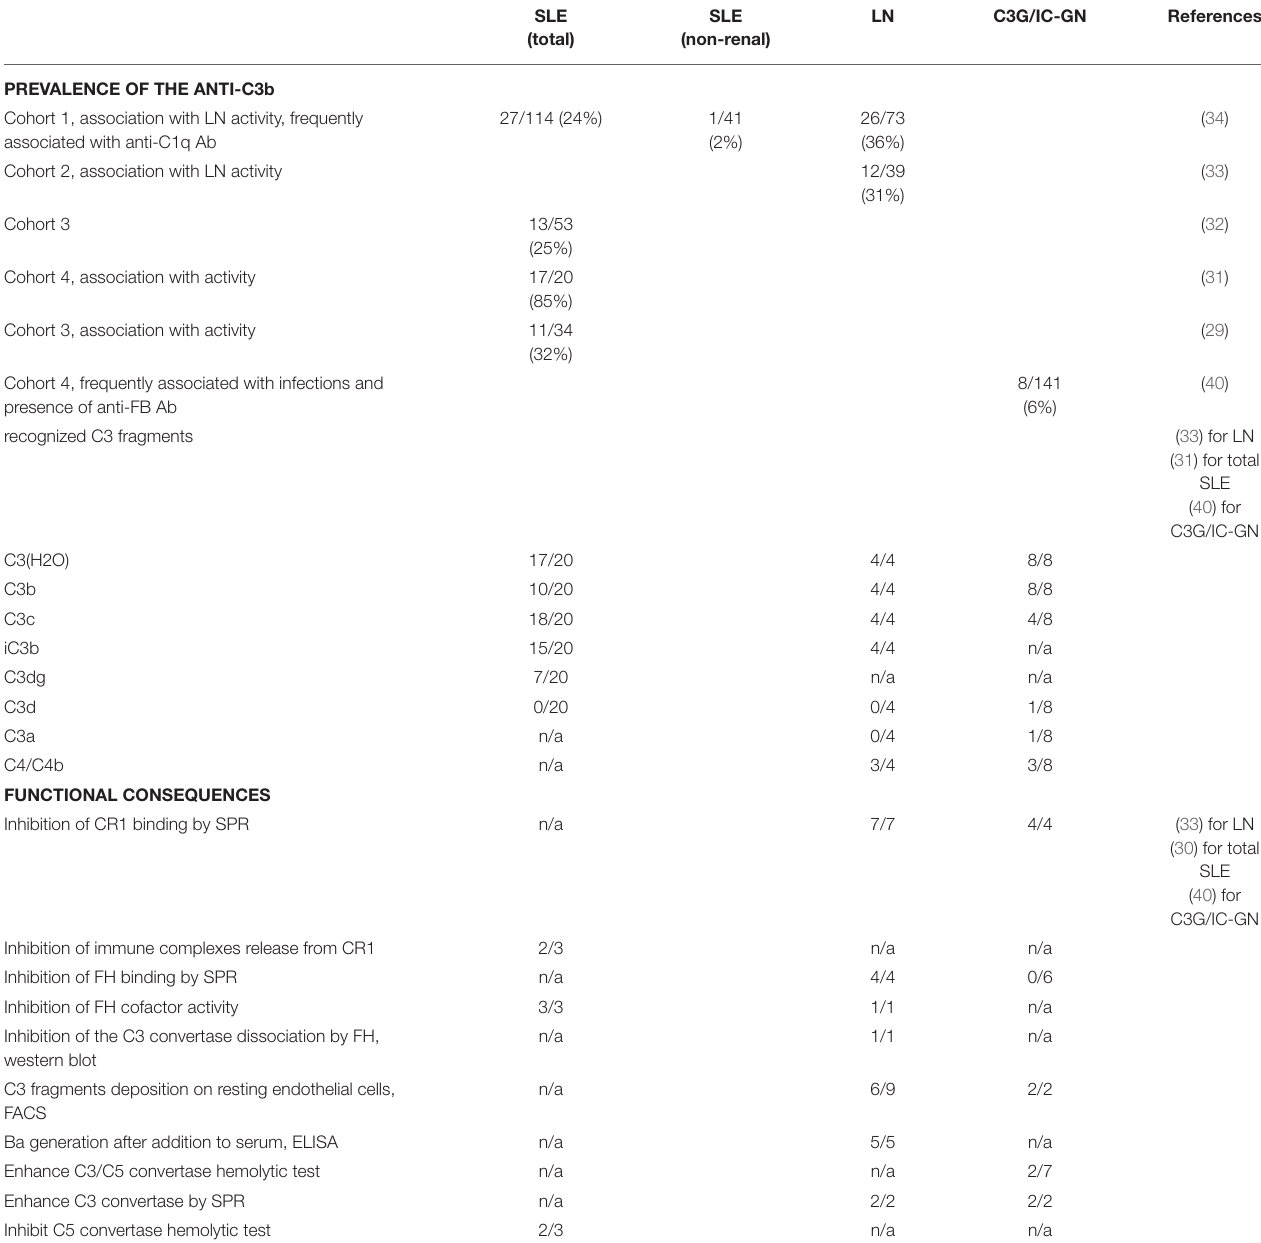
TABLE 1 | Prevalence and functional consequences of the anti-C3b Ab in autoimmune diseases (cohort